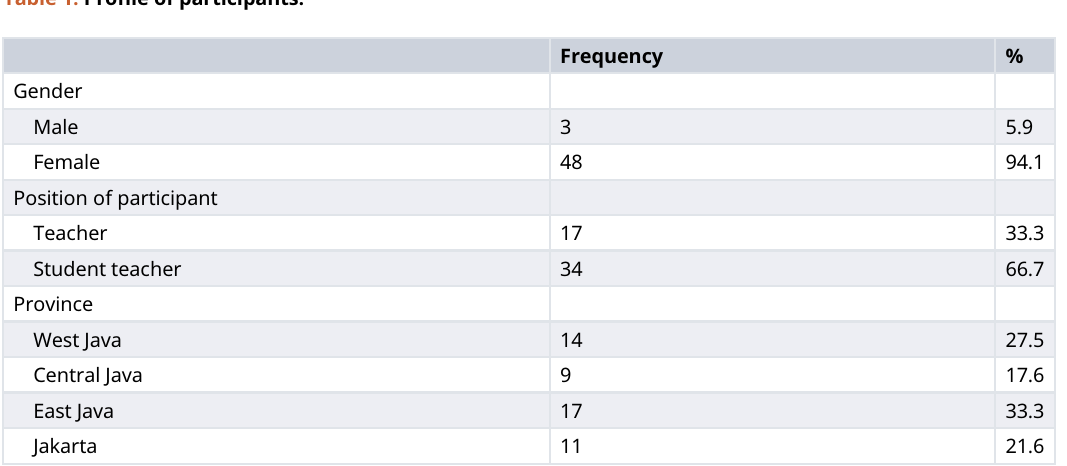
Table 1. Profile of